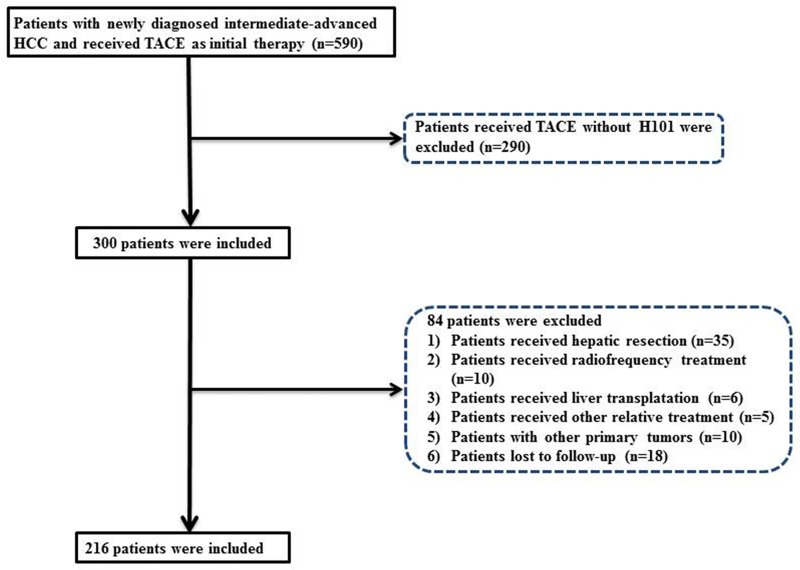
Flowchart of the patient selection process.